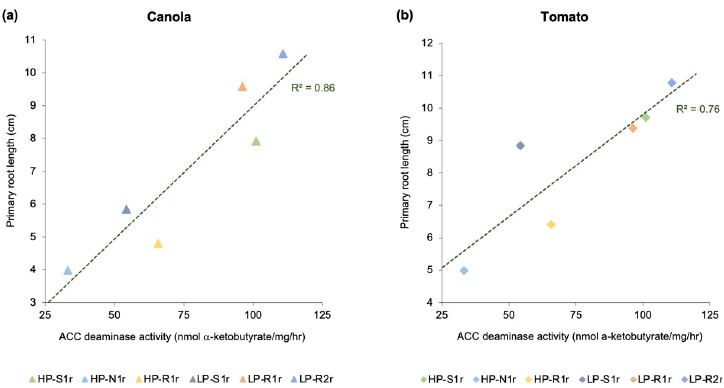
Fig 6. Correlation of in vitro ACC deaminase activity (x-axis) with primary root length (y-axis) of (a) canola and (b) tomato seedlings. The in vitro ACC deaminase activity was measured as the amount of α -ketobutyrate produced per mg protein in an hour. The primary root length of canola and tomato enhanced by each bacterial strain ( Caballeronia sordidicola HP-S1r, Pseudomonas frederiksbergensis HP-N1r, Phyllobacterium myrsinacearum HP-R1r, Pseudomonas mandelii LP-S1r, Paraburkholderia phytofirmans LP-R1r and Caballeronia udeis LP-R2r)reflects the in vivo ACC deaminase